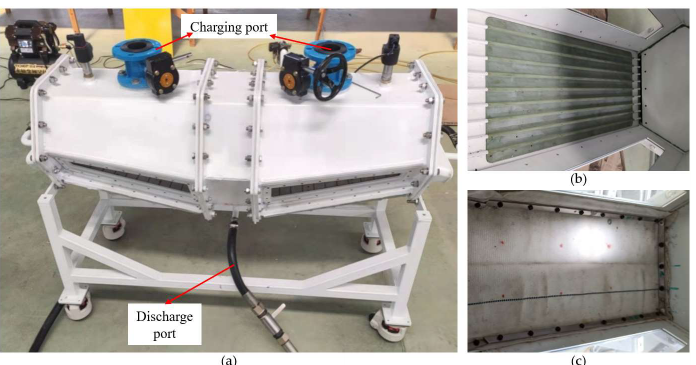
Figure 8. Unloading experimental device. ( a ) Scaled model ; ( b ) Airway display ; ( c ) Breathable cloth . Figure 9a,b present the test results of Schemes 1 and 12, respectively. The experi- mental results showed that in the model using Scheme 12, a large amount of powder re- mained in the corners of the fluidized bed after unloading, forming a dead zone of fluid- ization, while the model using Scheme 1 had a significantly reduced amount of powder residue and a significantly smaller dead zone after unloading. The residual powder was weighed and the powder residual rate was about 0.23% for Scheme 1 and 0.34% for Scheme 12. In addition, the overall fluidization effect of Scheme 1 was better . The exper- imental results are consistent with those obtained by the Taguchi method, which can also prove the correctness of the numerical simulation method in this paper.